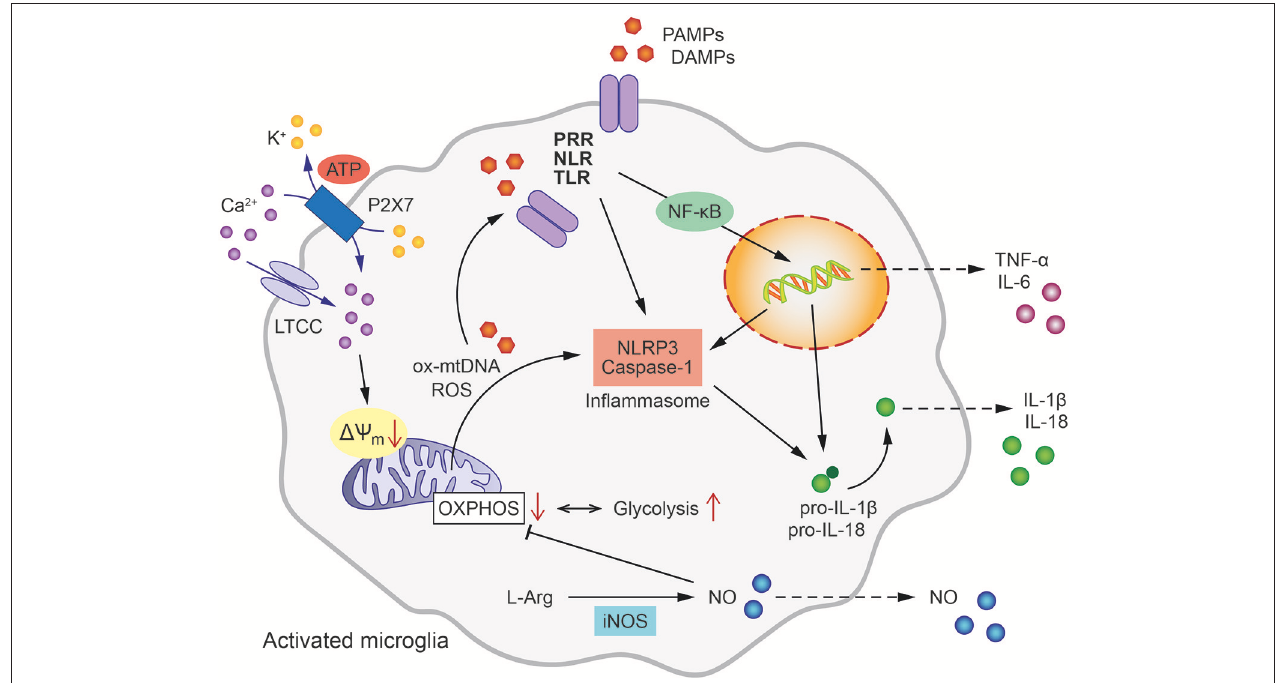
FIGURE 1 | Mitochondrial involvement in microglial activation and inflammatory signaling. Microglial activation pathways and inflammatory cytokine release are initiated by the binding of pathogen- or damage-associated molecular patterns (PAMPs/DAMPs) to intracellular or membrane-bound pattern recognition receptors (PRR), such as NOD-like receptors (NLR) or Toll-like receptors (TLR). This triggers NLRP3 and Caspase-1 assembly to form the inflammasome leading to the processing of pro-IL-1 β as well as pro-IL-18 to active IL-1 β and IL-18, respectively. In addition, oxidized mitochondrial DNA (ox-mtDNA) and mitochondrial reactive oxygen species (ROS) are canonical activators of inflammasome formation. Tumor necrosis factor (TNF) and Interleukin-6 (IL-6) are generated via nuclear factor NF- κ B-dependent transcriptional activation. The oxidation of L-arginine (L-Arg) by inducible nitric oxide synthase (iNOS) produces NO (Nitric oxide), which in turn inhibits oxidative phosphorylation (OXPHOS) shifting the energy metabolism of the cell toward glycolysis. Ca 2 + influx via L-type calcium channels (LTCC) and ATP-binding purinoceptors (P2X7) results in the loss of mitochondrial membrane potential ( 19 m), enhanced mitochondrial ROS formation and further contributes to inflammasome formation and pro-inflammatory activation of